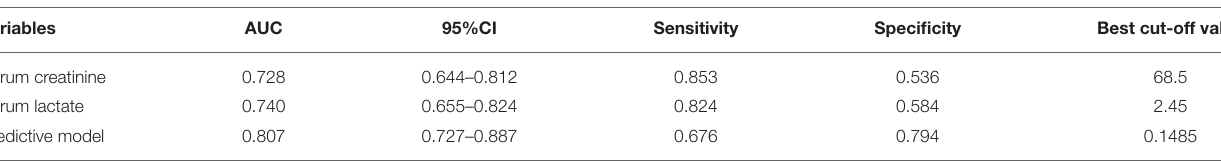
TABLE 3 | Predictive value of single lactate and the logistic